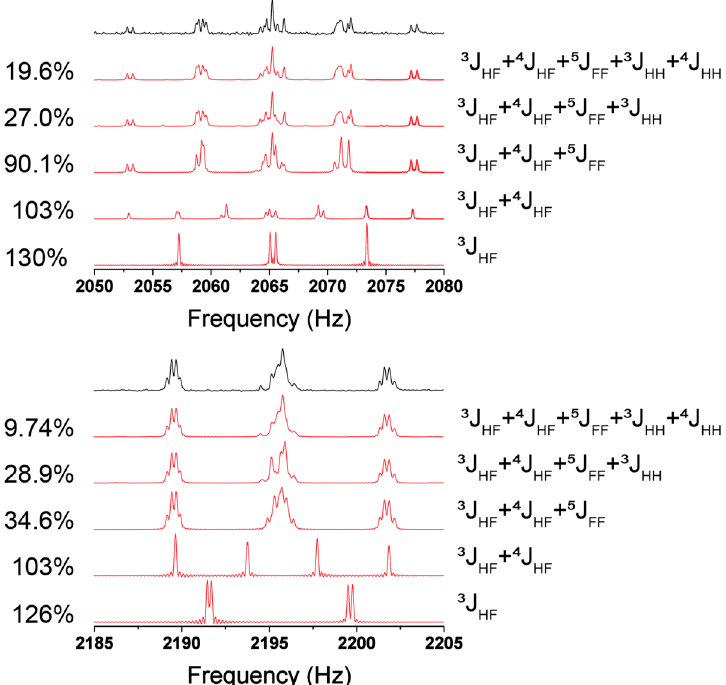
Figure 9. The simulated (red) and experimental spectra (black) of the 19 F (top) and 1 H (bottom) regions of 1,4-difluorobenzene. From bottom to top, the simulated spectra each contained an additional J -coupling, which appears to the right of each spectrum. Clearly, the subspectra in the experimental spectrum are well simulated only when all heteronuclear and homonuclear J -couplings were included, as denoted by the R -factor, which is included to the left of each simulated spectrum.